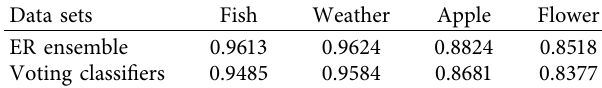
Table 1: Comparison of ER classifer and vote classifer.